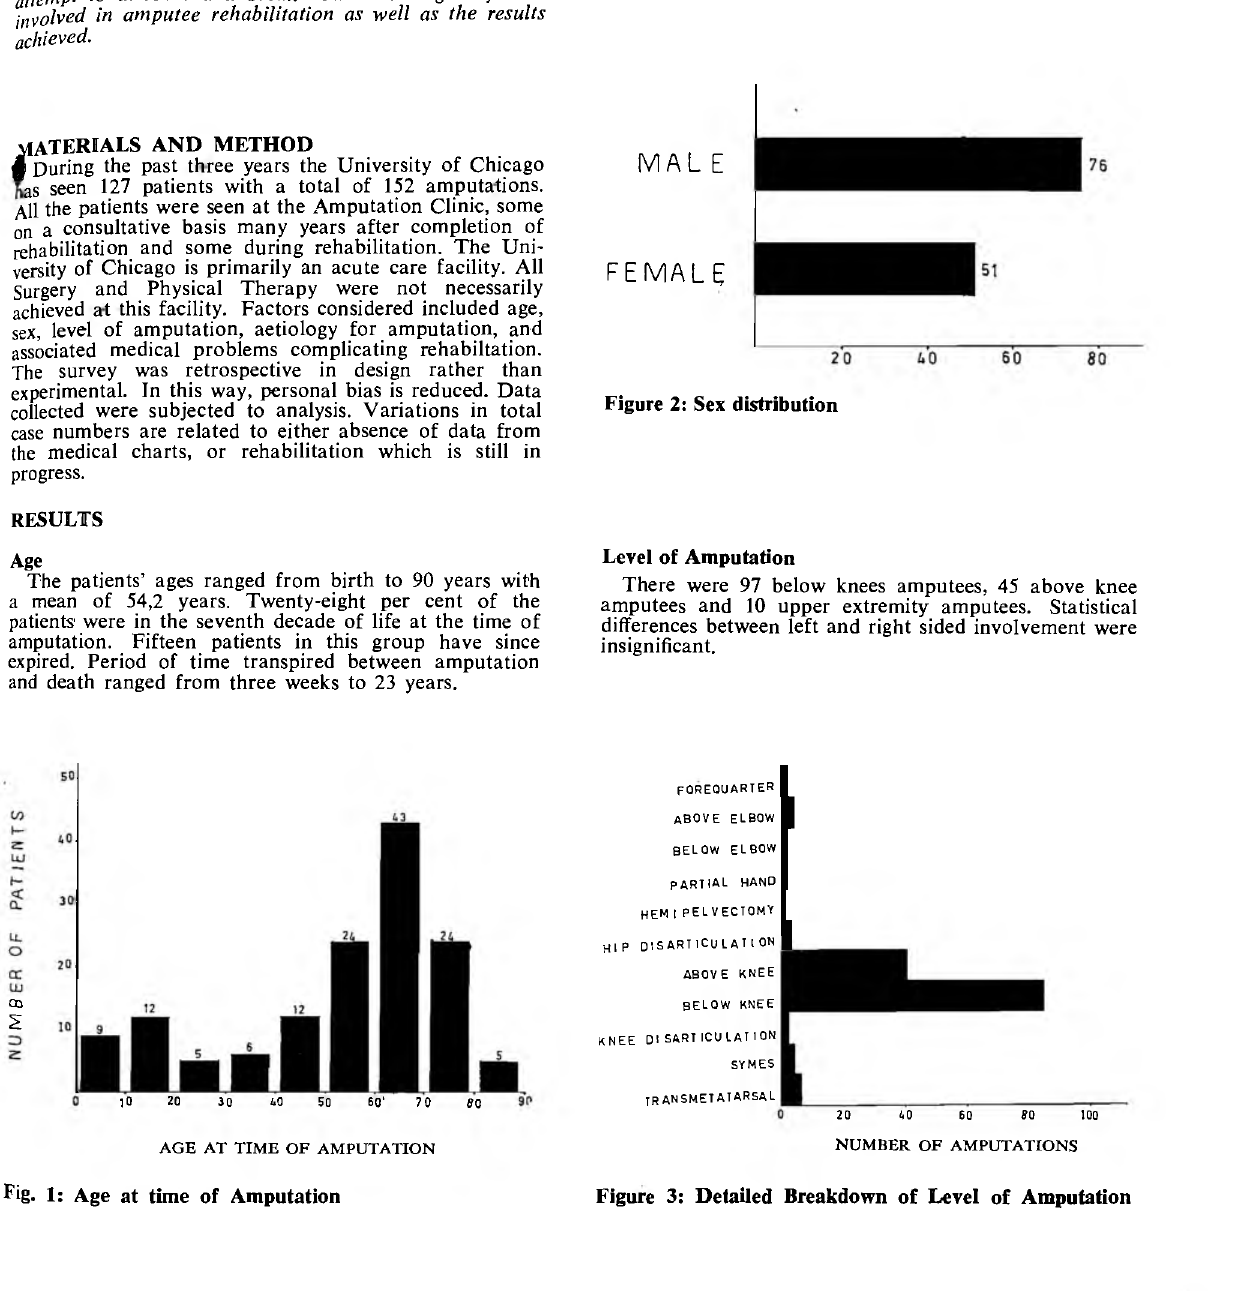
Figure 2: Sex distribution